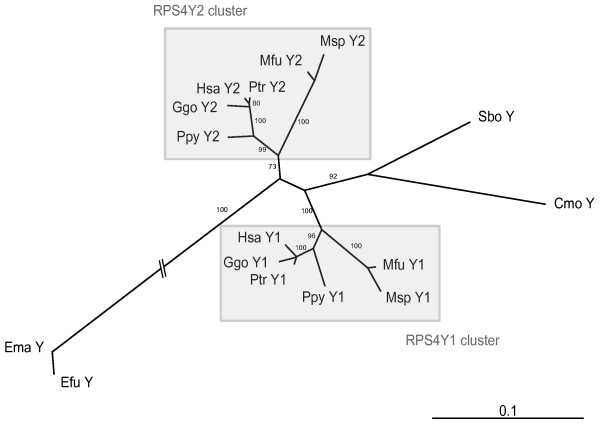
Neighbor-joining tree with model TVM+G of concatenated region1 and region2 for RPS4Y1 and RPS4Y2 built with PAUP after GBlocks region selection (787 bp). Cja was excluded when performing the analyses since its sequence was too short. Boostrap values (10,000 replicates) are shown on each branch.